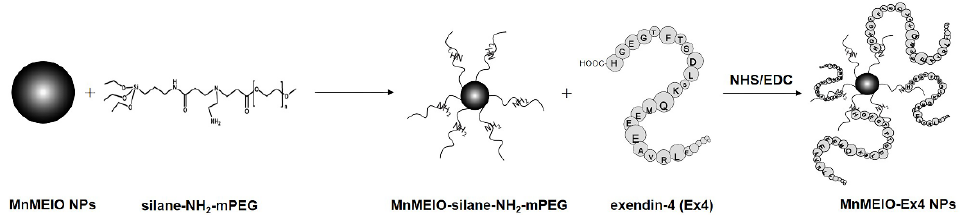
Figure 1. Schematic illustration of the synthetic process for MnMEIO-Ex4